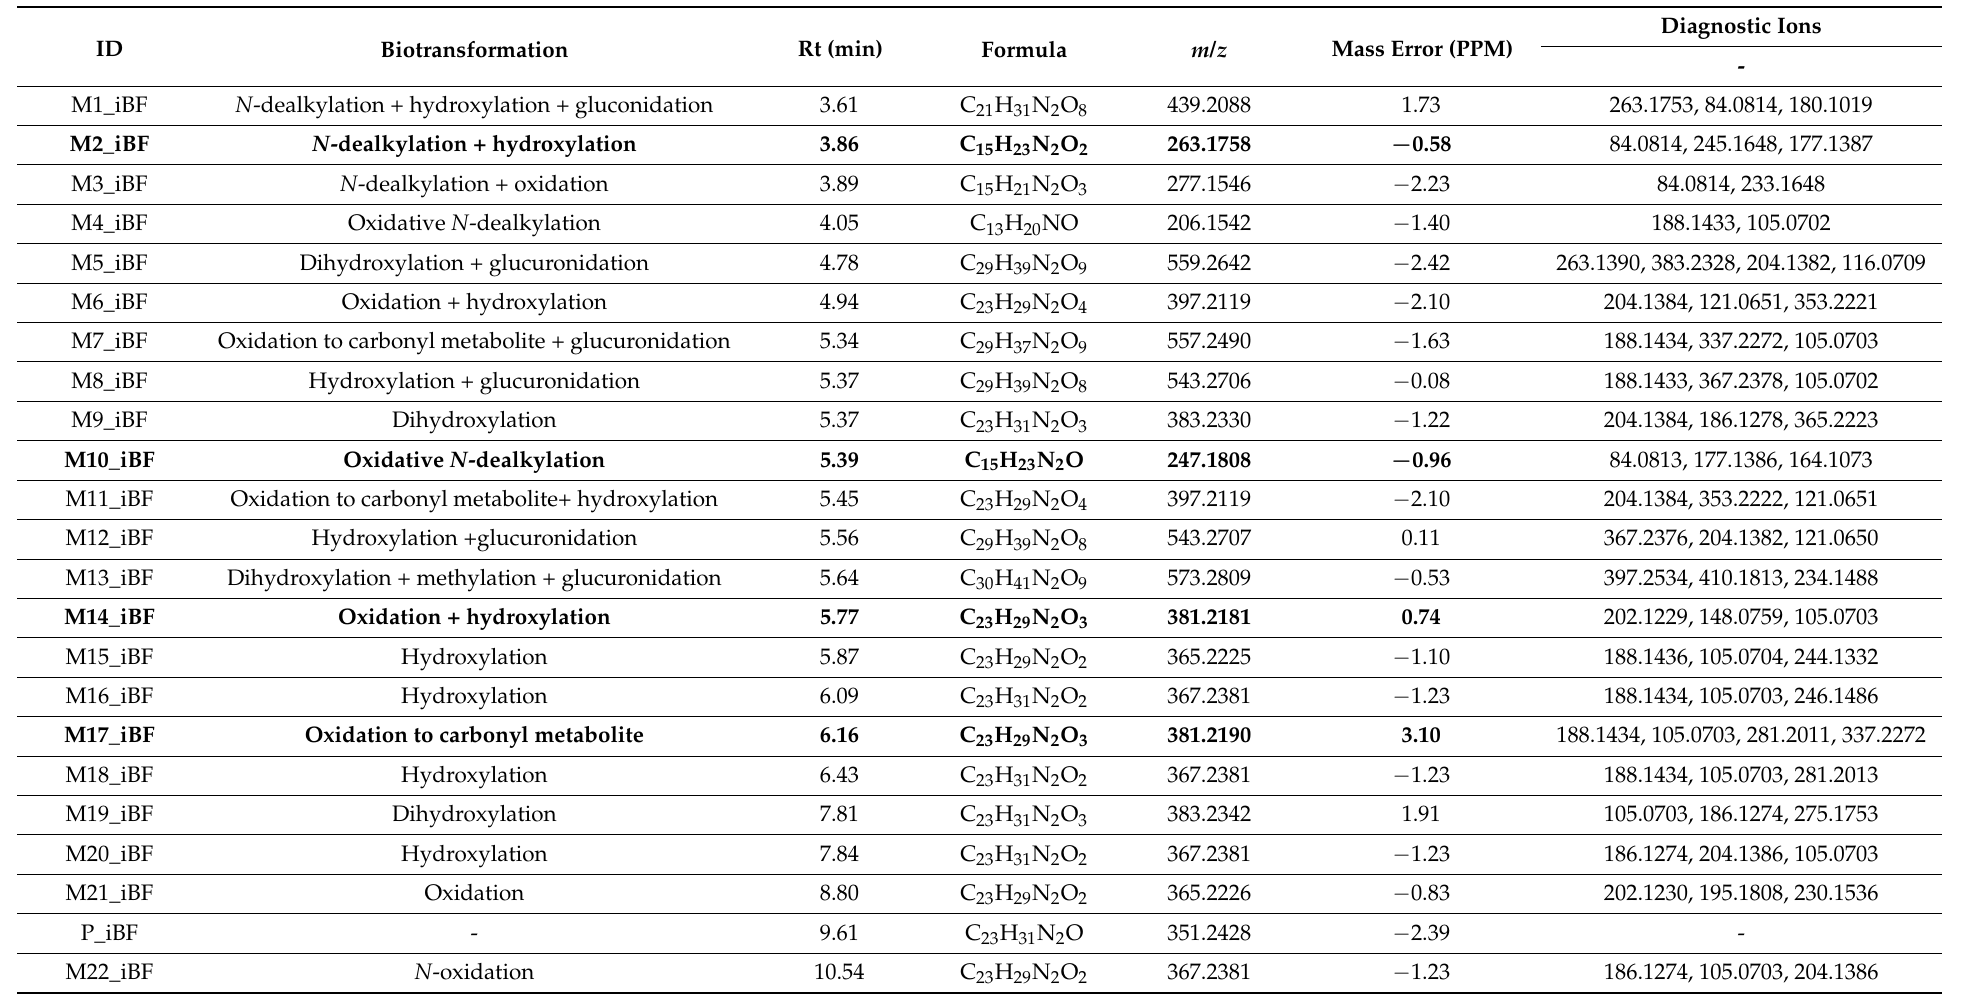
Table 3. List of proposed metabolites of isobutyrylfentanyl with the main identification parameters and postulated biotransformation. The relatively most intense metabolites are in